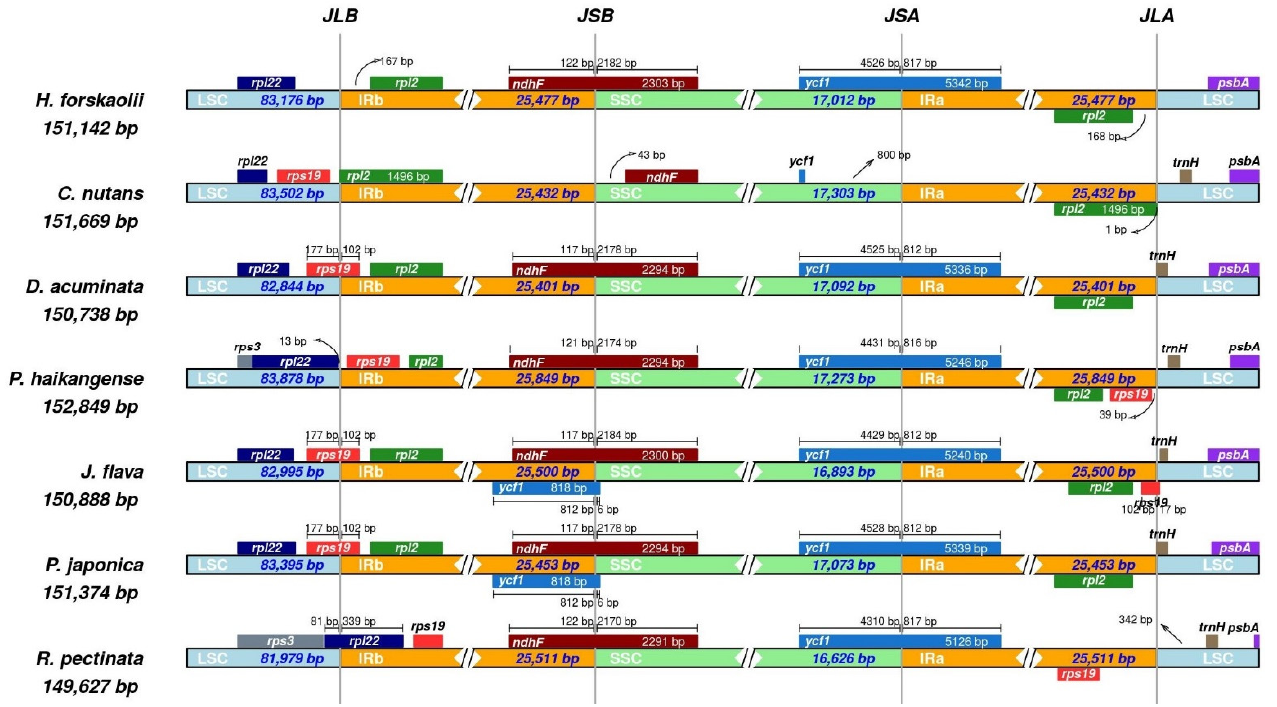
Figure 6. Structural variation in the junction of inverted repeat and single copy regions among the seven cp genomes of Justiceae. (JSA: Junction of the SSC and the IRA; JLB: Junction of the LSC and the IRB; JSB: Junction of the SSC and the IRB).